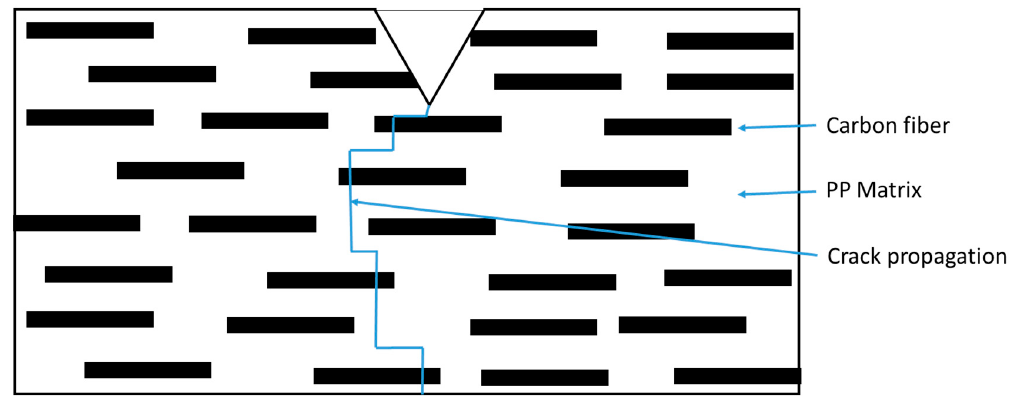
Figure 15. Illustration of impact crack propagation on polypropylene (PP)/short carbon fiber (SCF) composites.